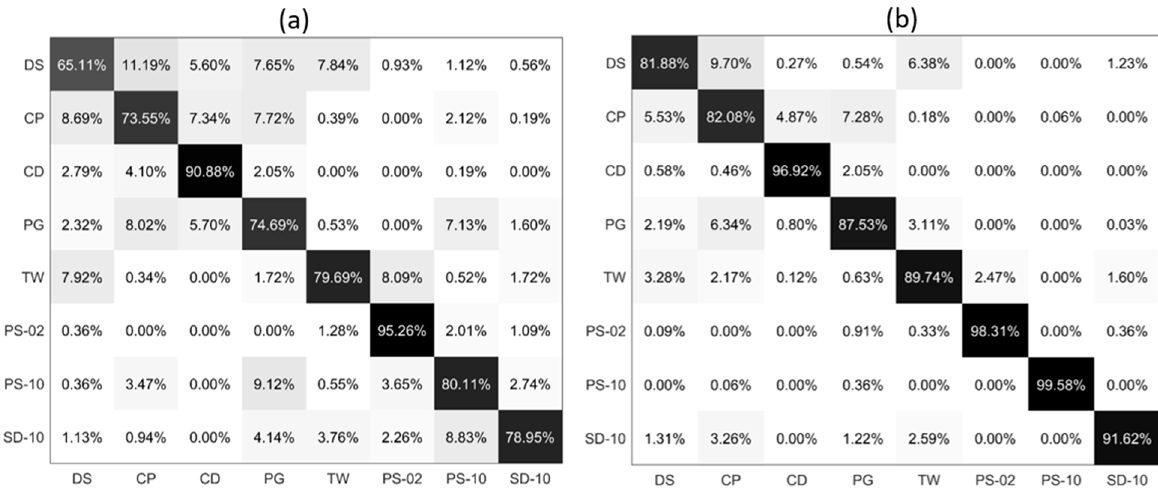
Figure 5. The confusion matrix of eight suspended particles classification: ( a ) PLP-Ave model; ( b ) PLP-All model. The classification accuracy of the eight suspended particles in the training and test sets using the PLP-Ave and PLP-All models are shown in Table 3. The model’s classification accuracy which is trained by the data of the PLP-All model is larger by 10.70% than the PLP-Ave model, which indicates that this model has stronger feature extraction capabilities. Table 3. Accuracy of PLP-Ave model and PLP-All